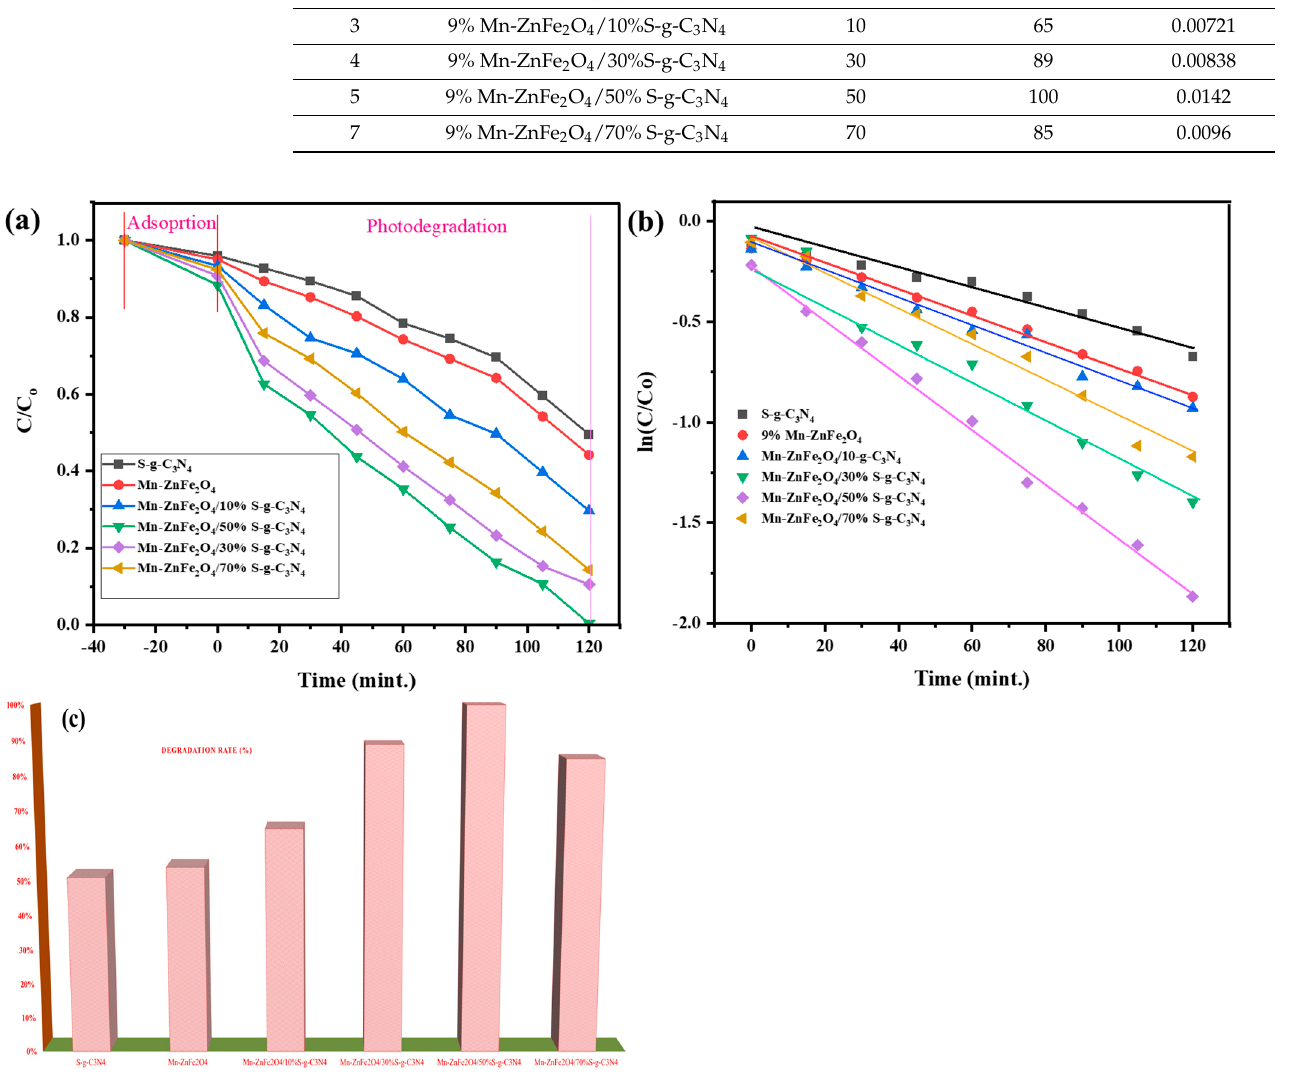
Figure 5. Photocatalytic degradation rate ( a ), % degradation ( b ), and kinetic characteristics of MB by Mn-ZnFe 2 O 4 /S-g-C 3 N 4 NCs ( c Table 3. Comparison of photocatalytic efficiency of the Mn-ZnFe 2 O 4 /S-g-C 3 N 4 NCs with some pre- vious works.